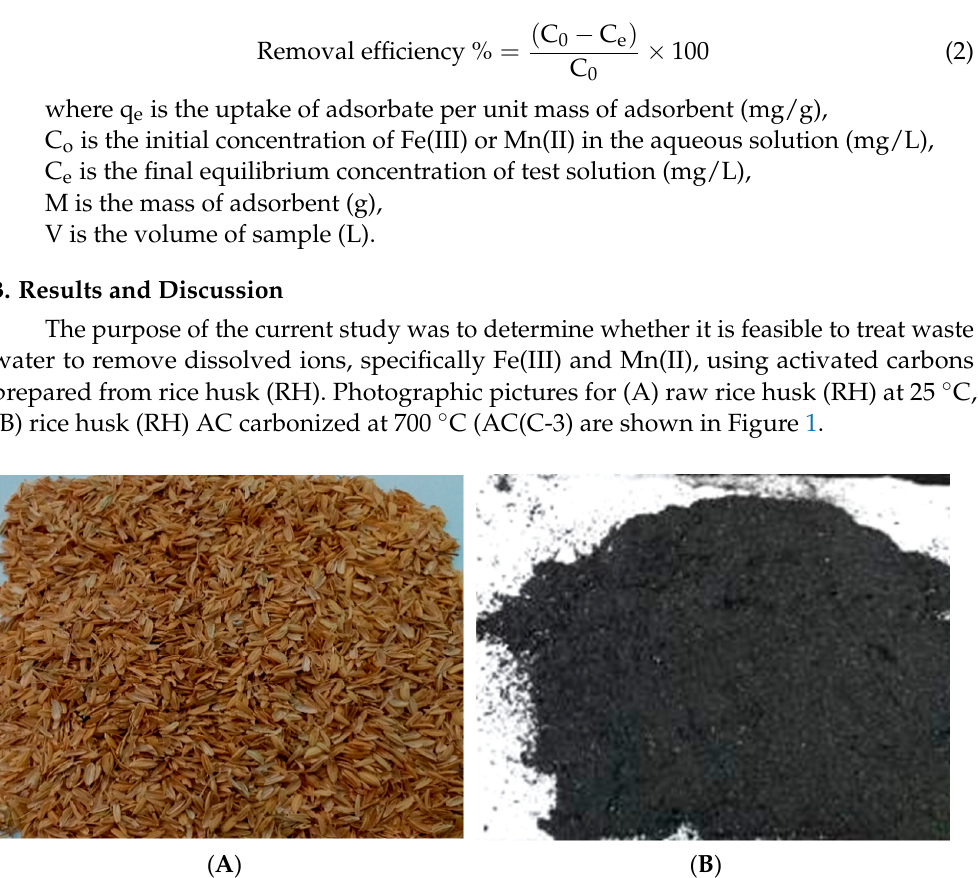
Figure 1. Photographic pictures for ( A ) raw rice husk (RH) at 25 °C, ( B ) rice husk (RH) AC carbonized at 700 °C (AC(C-3)).